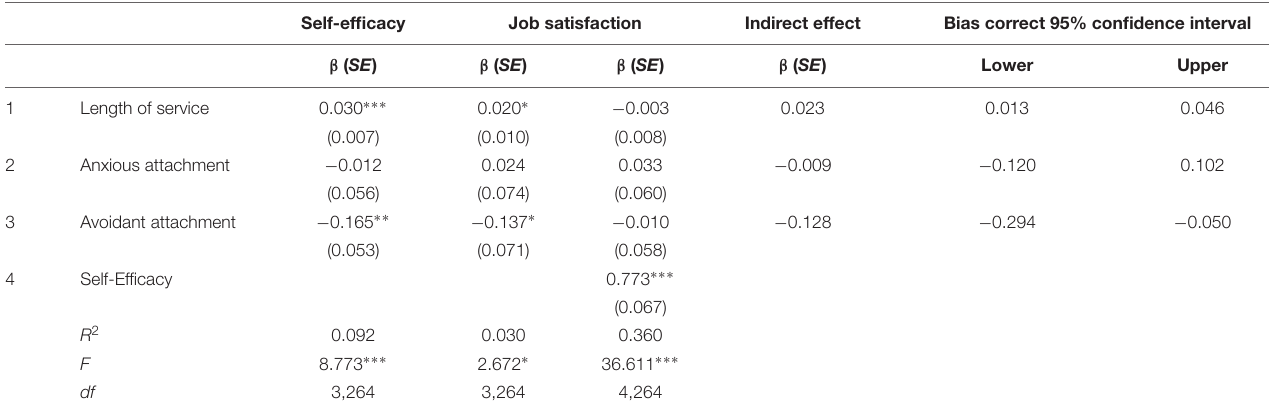
TABLE 2 | Mediation effects of job satisfaction on self-efficacy ( N =